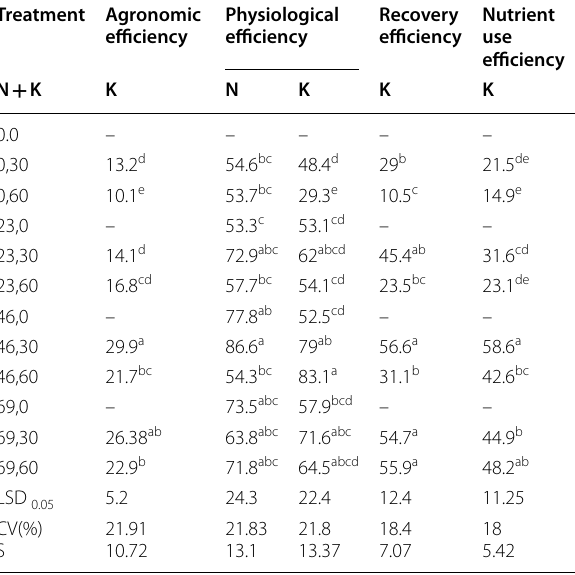
Table 8 Agronomic, physiological, crop recovery and total use efficiency affected by the rate of N and K fertilizers